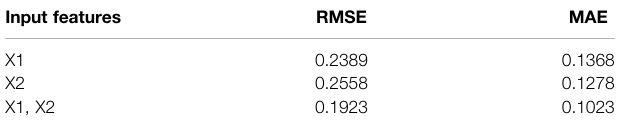
TABLE 4 | Errors of predicted results with changing